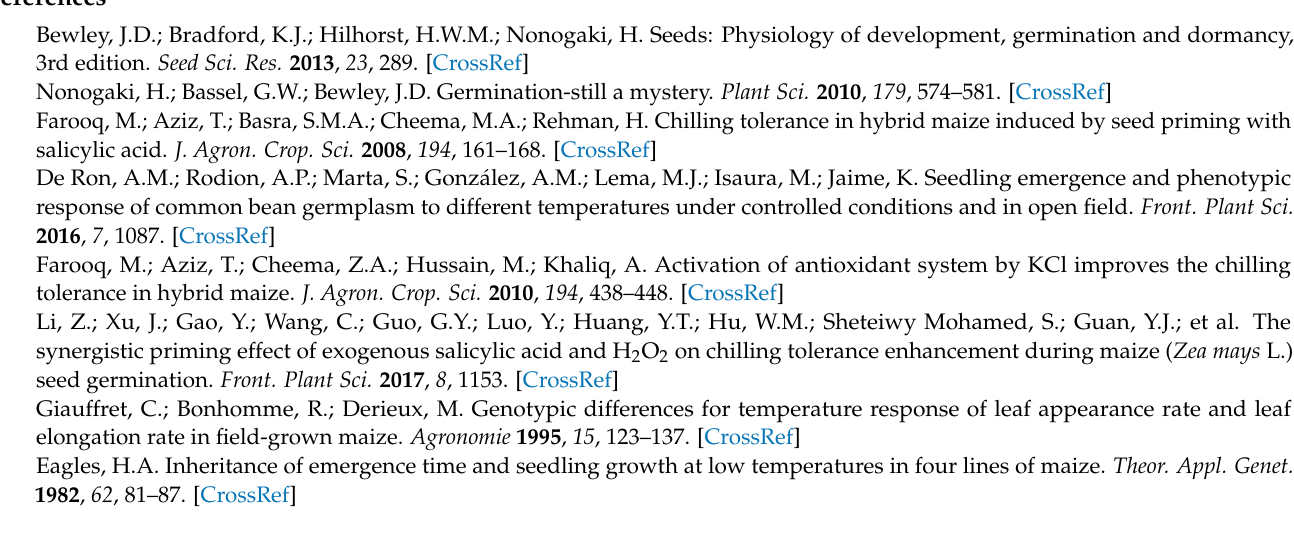
Table S2: Metabolites screened and Q1/Q3